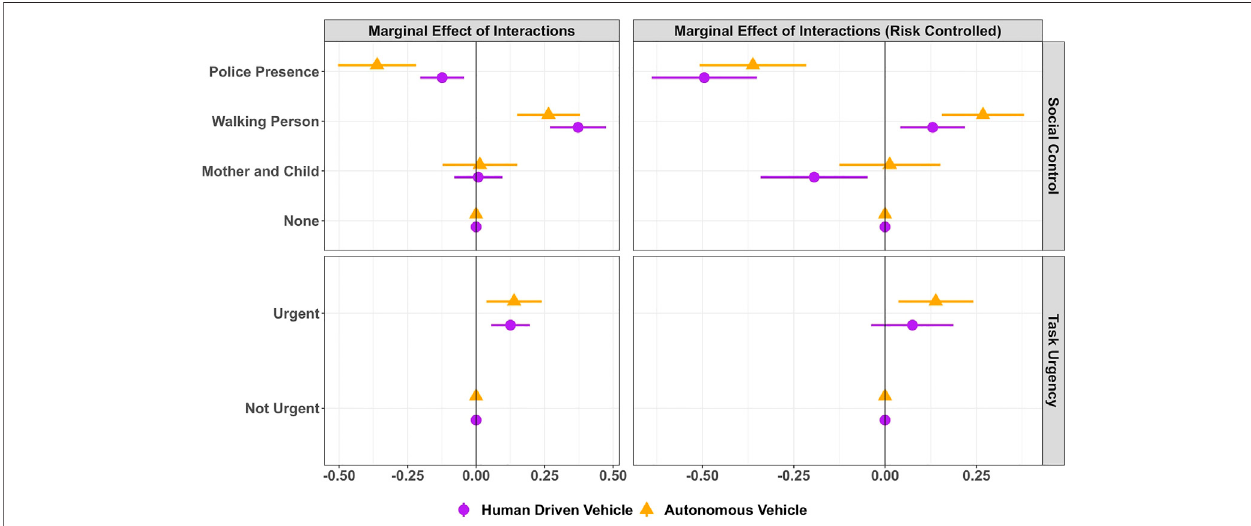
FIGURE8| Effectofsocialcontrolandtaskurgencyconditionedbyvehicletype.Note:the fi gureillustratestheaveragemarginaleffectsoncrossingprobabilitiesof social control and task urgency, conditioned on vehicletype, both for the baselinecrossing decision under uncertainty of HDV behavior (left side) and interactionswhere participantswerefacedwiththeequalriskofcollisionbetweenAVand HDV(rightside). Purplepoints represent HDV,andorangetrianglesrepresentAV.Horizontallines show 95% CIs. Vertical lines represent the average crossing probability of the reference level.